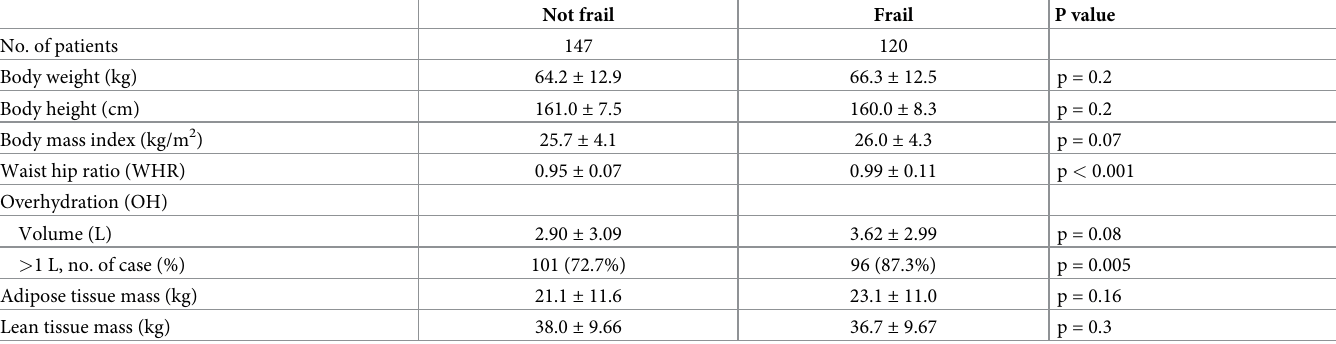
Table 2. Body anthropometry and composition by bioimpedance spectroscopy.